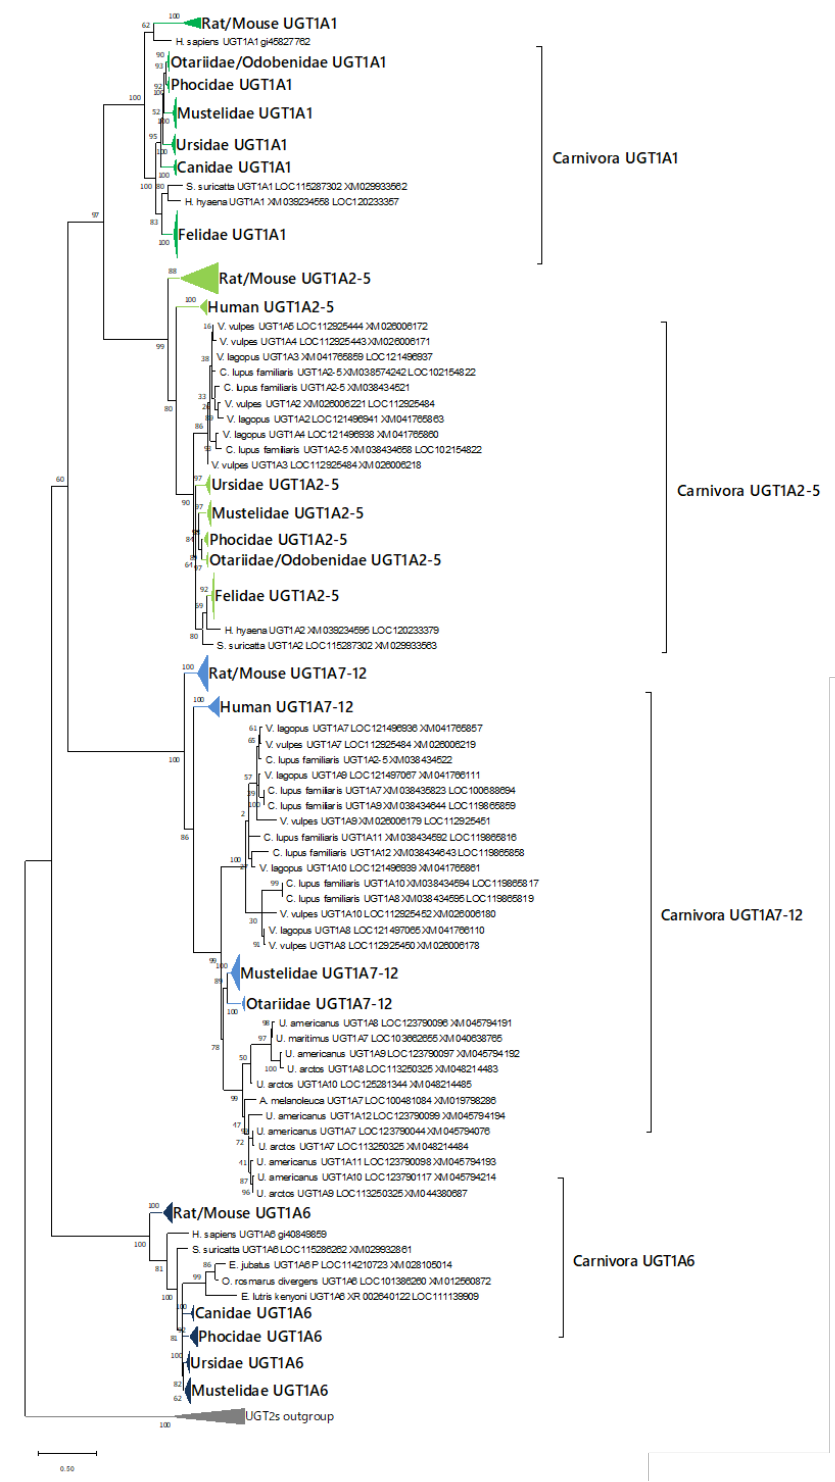
Figure 4. Phylogenetic tree of UGT1As. Phylogenetic tree of UGT1A sequences in human, mouse, rat, and carnivorans. Gene sequences of protein-coding regions for each isozyme were analyzed. The numbers next to the branches indicate the number of occurrences per 100 bootstrap replicates. Genes and clades are tentatively labeled with carnivoran UGTs examined in this article. Clades of rodents, and human UGT1A1, UGT1A2–5, UGT1A6, and UGT1A7–12 in the phylogenetic tree are shown as triangles of the following colors: dark green for UGT1A1s, bright green for UGT1A2–5s, deep blue for UGT1A6s, and pale blue for UGT1A7–12s. UGT2As are shown as an